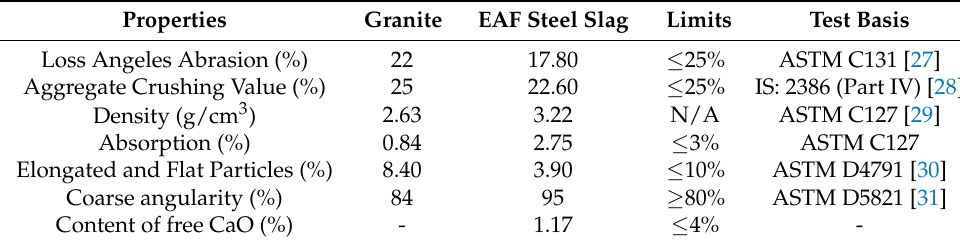
Table 2. Characteristics of the aggregates.